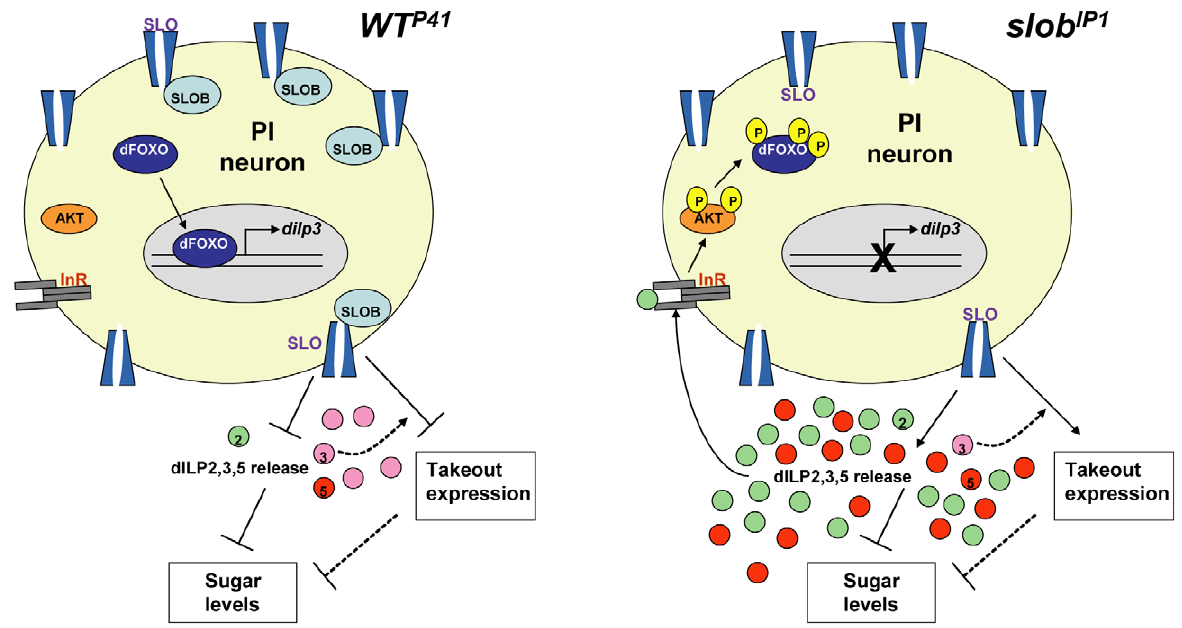
Figure 8. Proposed function of SLOB in mNSCs. SLOB, through inhibitory modulation of SLO, influences dILP release from mNSCs and gene expression of to and dilp3 . Slob null flies have elevated SLO activity, resulting in opposite effects on IIS and gene expression. Arrows denote positive regulation, while blunted lines denote negative regulation. Dotted lines denote relationships that are still unclear. See text for further details.